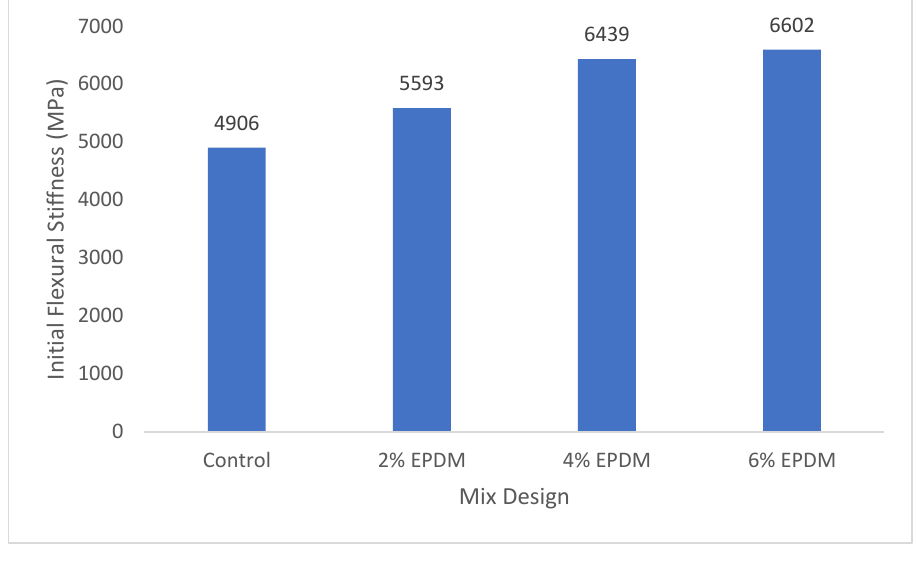
Figure 7. Initial flexural stiffness results.